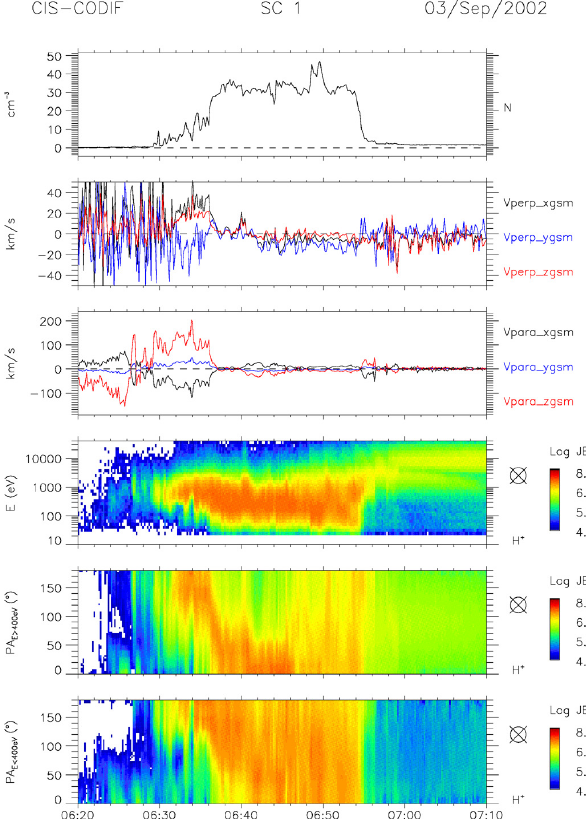
Fig. 3. CIS-CODIF data from SC1 with from top to bottom: the H+ density, the 3 GSM components of H+ velocity perpendicular and parallel to B , an energy-time H+ spectrogram, and two pitch angle-time spectrograms for H+ with E < 400eV and E > 400eV, as functions of universal time.